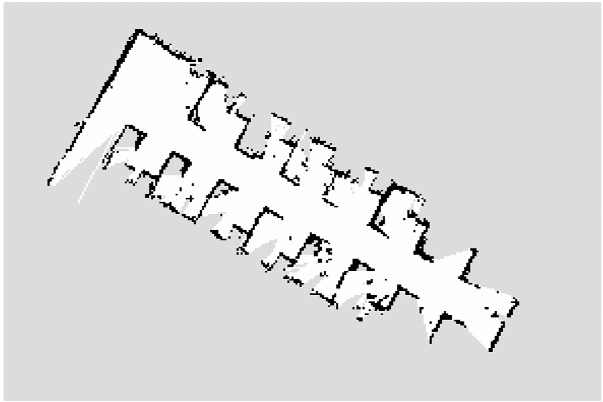
Figure 2. The scene map of the office made with Gmapping SLAM.